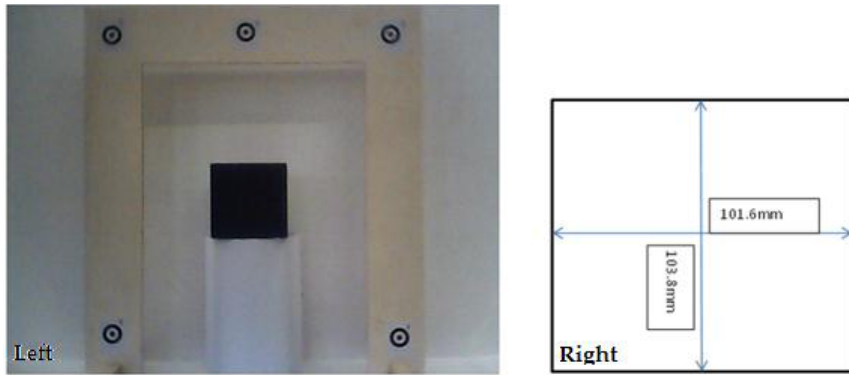
Figure 1. Metal cube and target frame used to provide a reference area ( Left ) and respective dimensions of the cube ( Right ).